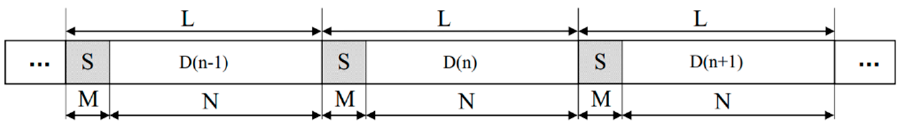
Figure 1. Frame sequence structure diagram.